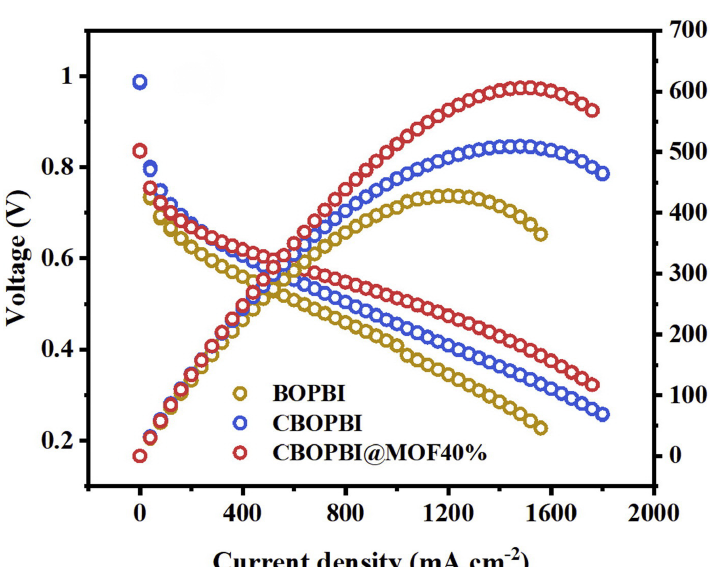
Figure 9. The voltage of CBOPBI@MOF40% (taken from Ref.